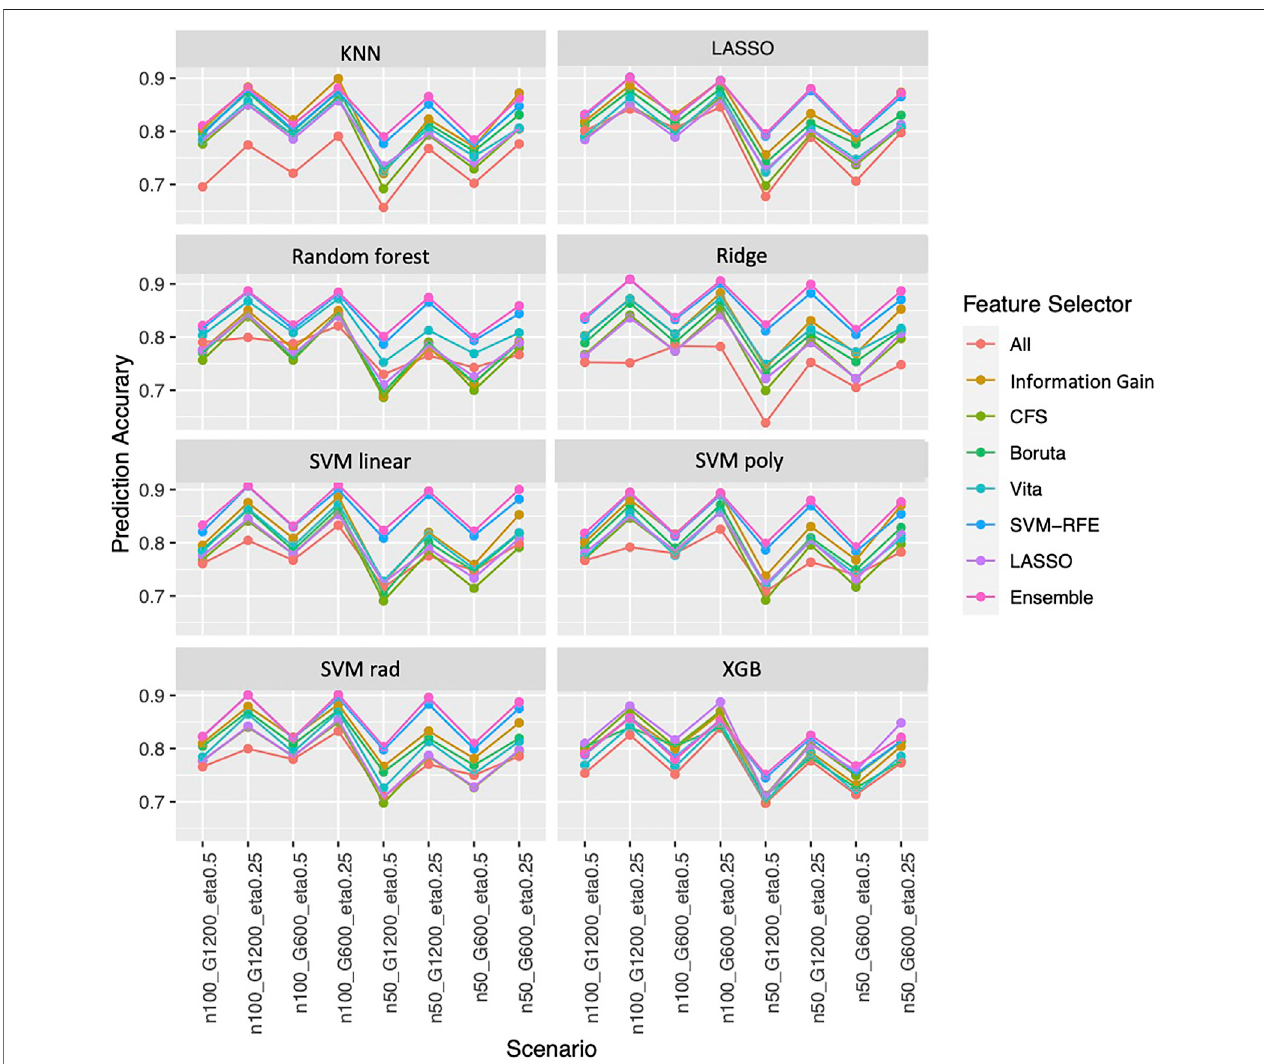
FIGURE 5 | Prediction accuracy based on simulation. Panels present the prediction accuracy for the corresponding classi fi cation approach as indicated. In each panel, x-axis stands for different simulation scenario listed in Table 2 . For example, n50_G600_eta0.5 stands for sample size is 50 with 600 candidate genes and the probability of the outcome is 0.5. Each colored curve stands for different feature selection approaches. The eight classi fi cation approaches are: SVM with linear (SVM linear), polynomial (SVM poly) and radius kernels (SVM rad) (Amari and Wu, 1999), K-nearest neighbors (KNN) (Dudani, 1976), Random Forest (Breiman, 2001), extreme gradient boosting (XGB) (Chen et al., 2015), Ridge (Le Cessie, Van Houwelingen) and LASSO (Tibshirani,